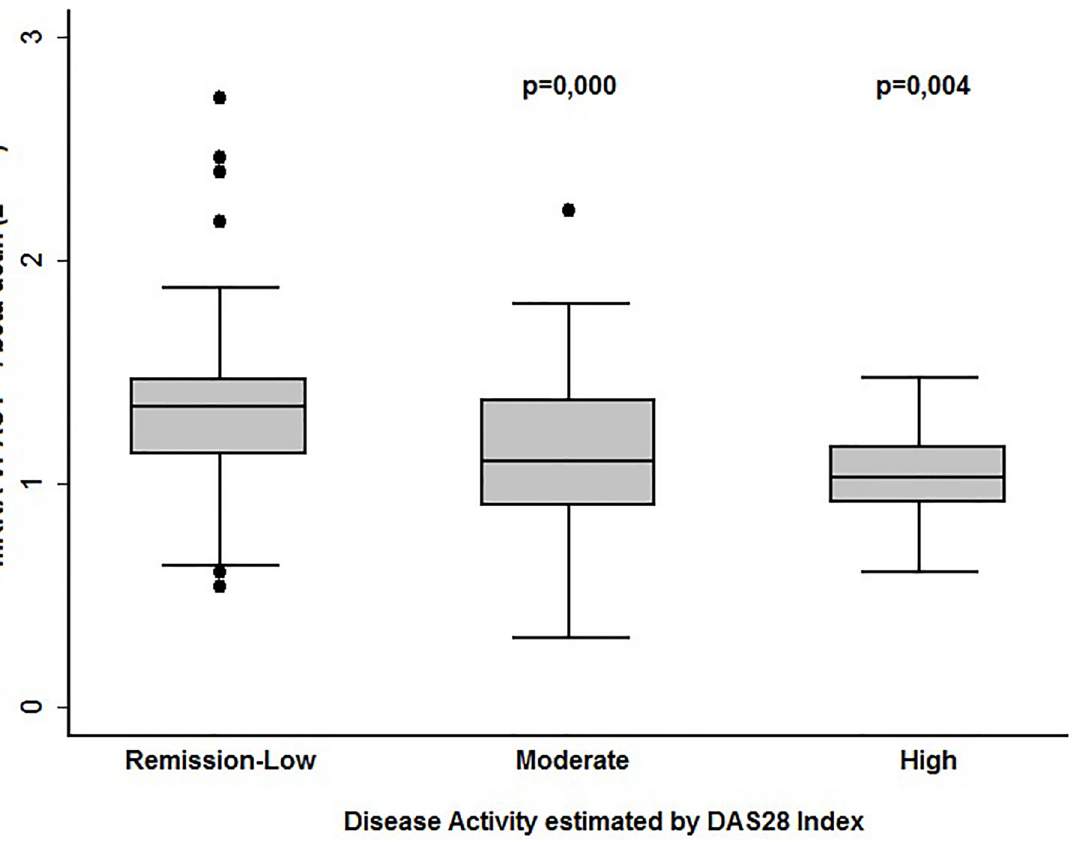
Fig 4. Correlation between VPAC1 gene expression levels and disease activity. Data are represented as the interquartile range (p75 upper edge of the box, p25 lower edge, p50 midline), p90 (line above the box) and p10 (line below the box). Mathematical transformation for VPAC1 expression: raised to 0.3. Dots represent outliers. Statistical significance was established using the Kruskal-Wallis test.